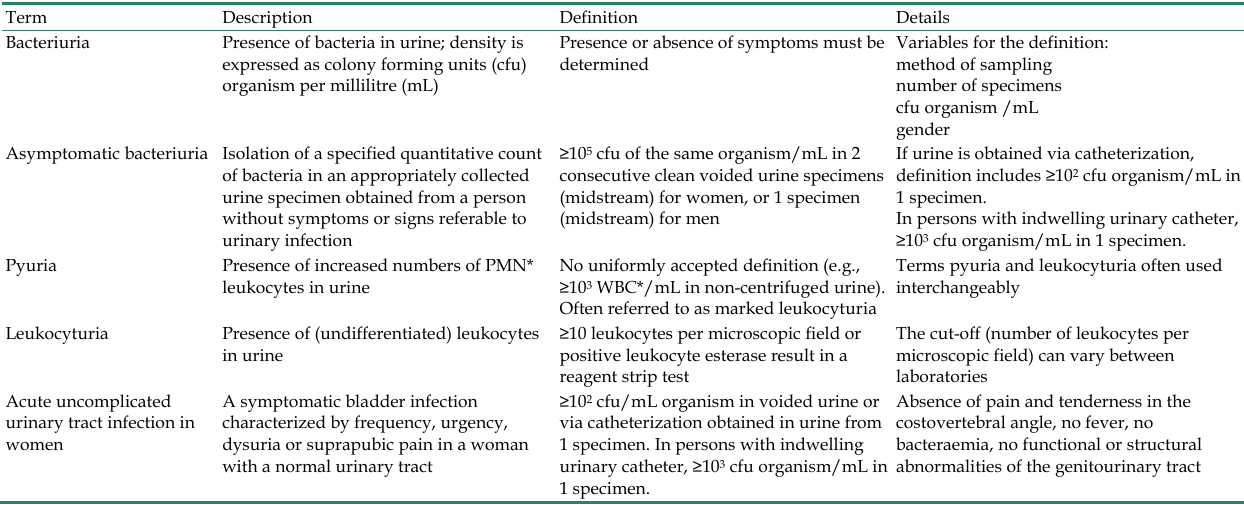
Table 1. Definitions for terms used to describe abnormal findings in urine